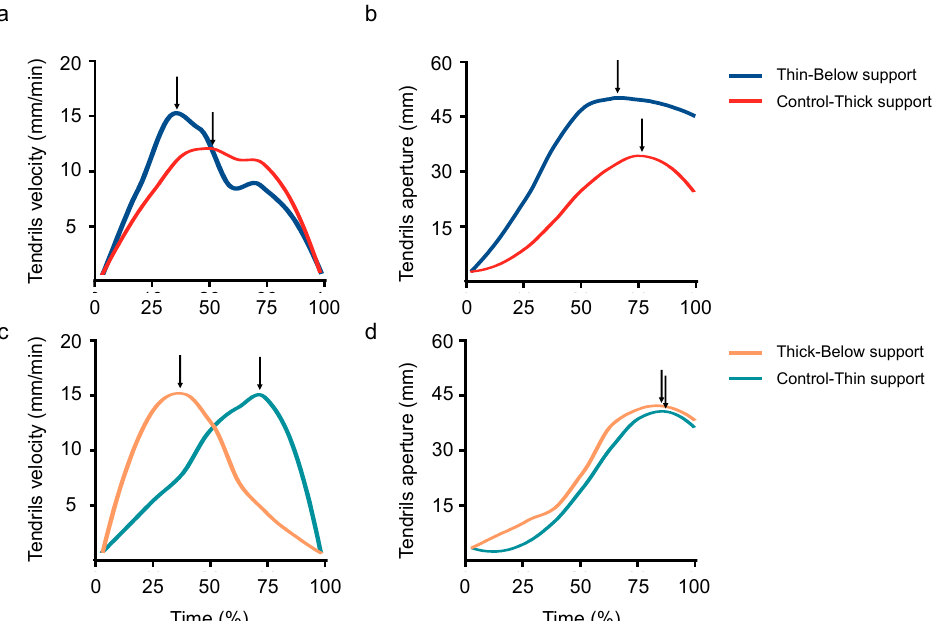
Figure 6. A graphical representation of the velocity ( a , c ) and the aperture of the tendrils ( b , d ) during the ‘Control-Thick’ (i.e., the red line) and the ‘Thin-Below’ conditions (i.e., the blue line) and during the ‘Control-Thin’ (i.e., the light blue line) and the Thick-Below conditions (i.e., the orange line). The arrows indicate the time the maximum peak velocity ( a , c ) and maximum peak aperture of the tendrils ( b , d ) occurred. Please note that for the perturbed trials (i.e., ‘Thin- and ‘Thick-Below’ condition) the peak velocity of the tendrils was reached earlier with respect to what happened during the control trials (i.e., ‘Control-Thin’ and ‘Control-Thick’ conditions; ( a , c )). Further, the peak of the maximum aperture of the tendrils occurred earlier for the ‘Thin-Below’ than for the ‘Control-Thick’ support ( b ). No differences were found in the maximum aperture of the tendrils and in the peak of the maximum aperture for the ‘Control-Thin’ and ‘Thick-Below’ conditions ( d